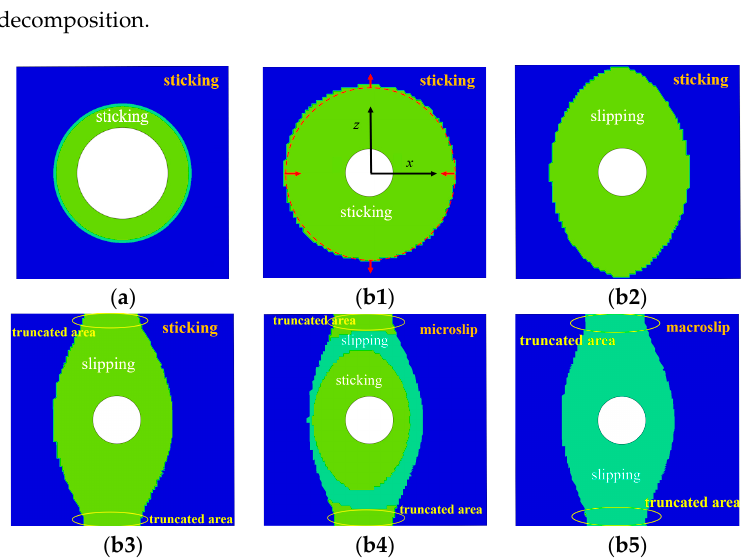
Figure 19. Force decomposition. T = 489.332 N, the contact boundary was truncated by the plate boundary in the z -direction. When 228.55 N ≤ T ≤ 489.332 N, the contact condition was sticking, and the mapping was mixed-mode loading, as shown in Figure 20a. The result indicates that that the force sustained by the Jenkins element was smaller than the minimum critical slip force ( k t u < f ∗ ). min boundary shrank in the x -direction and stretched in the z -direction, as shown in Figure 20b1–b3. When 228.55 N T =